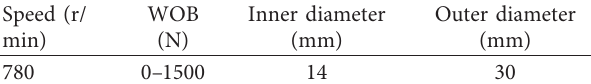
Table 5: Rotary ultrasonic drilling equipment